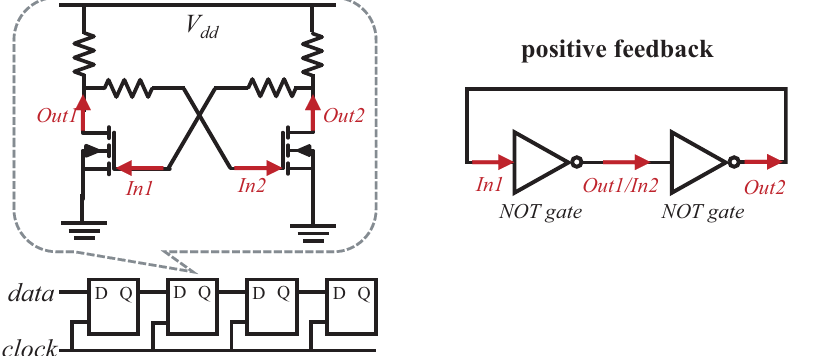
Figure 6. Rx register circuit diagram (4 bit). The kernel of a flip-flop (in the dashed box) is the same as a Schmitt